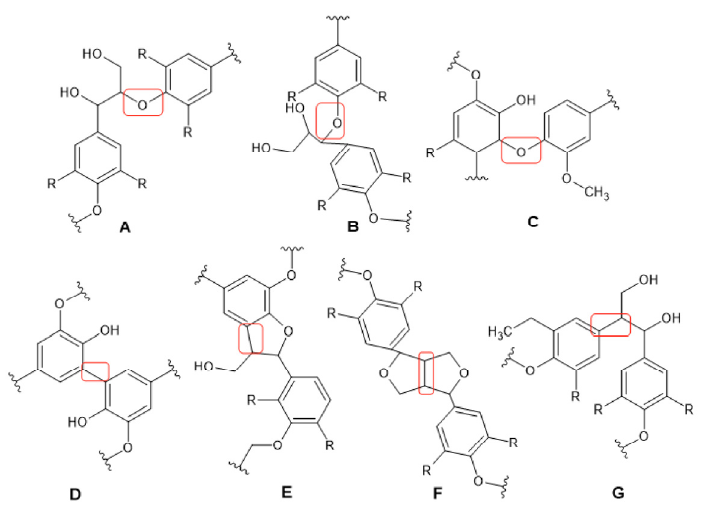
Figure 2. Chemical bonds found in lignin composed of both ether and carbon-carbon bonds (high- lighted in red). ( A ) β -O-4, ( B ) α -O-4, ( C ) 4-O-5, ( D ) 5-5, ( E ) β -5, ( F ) β - β , ( G ) β -1. (Adapted from [17]).